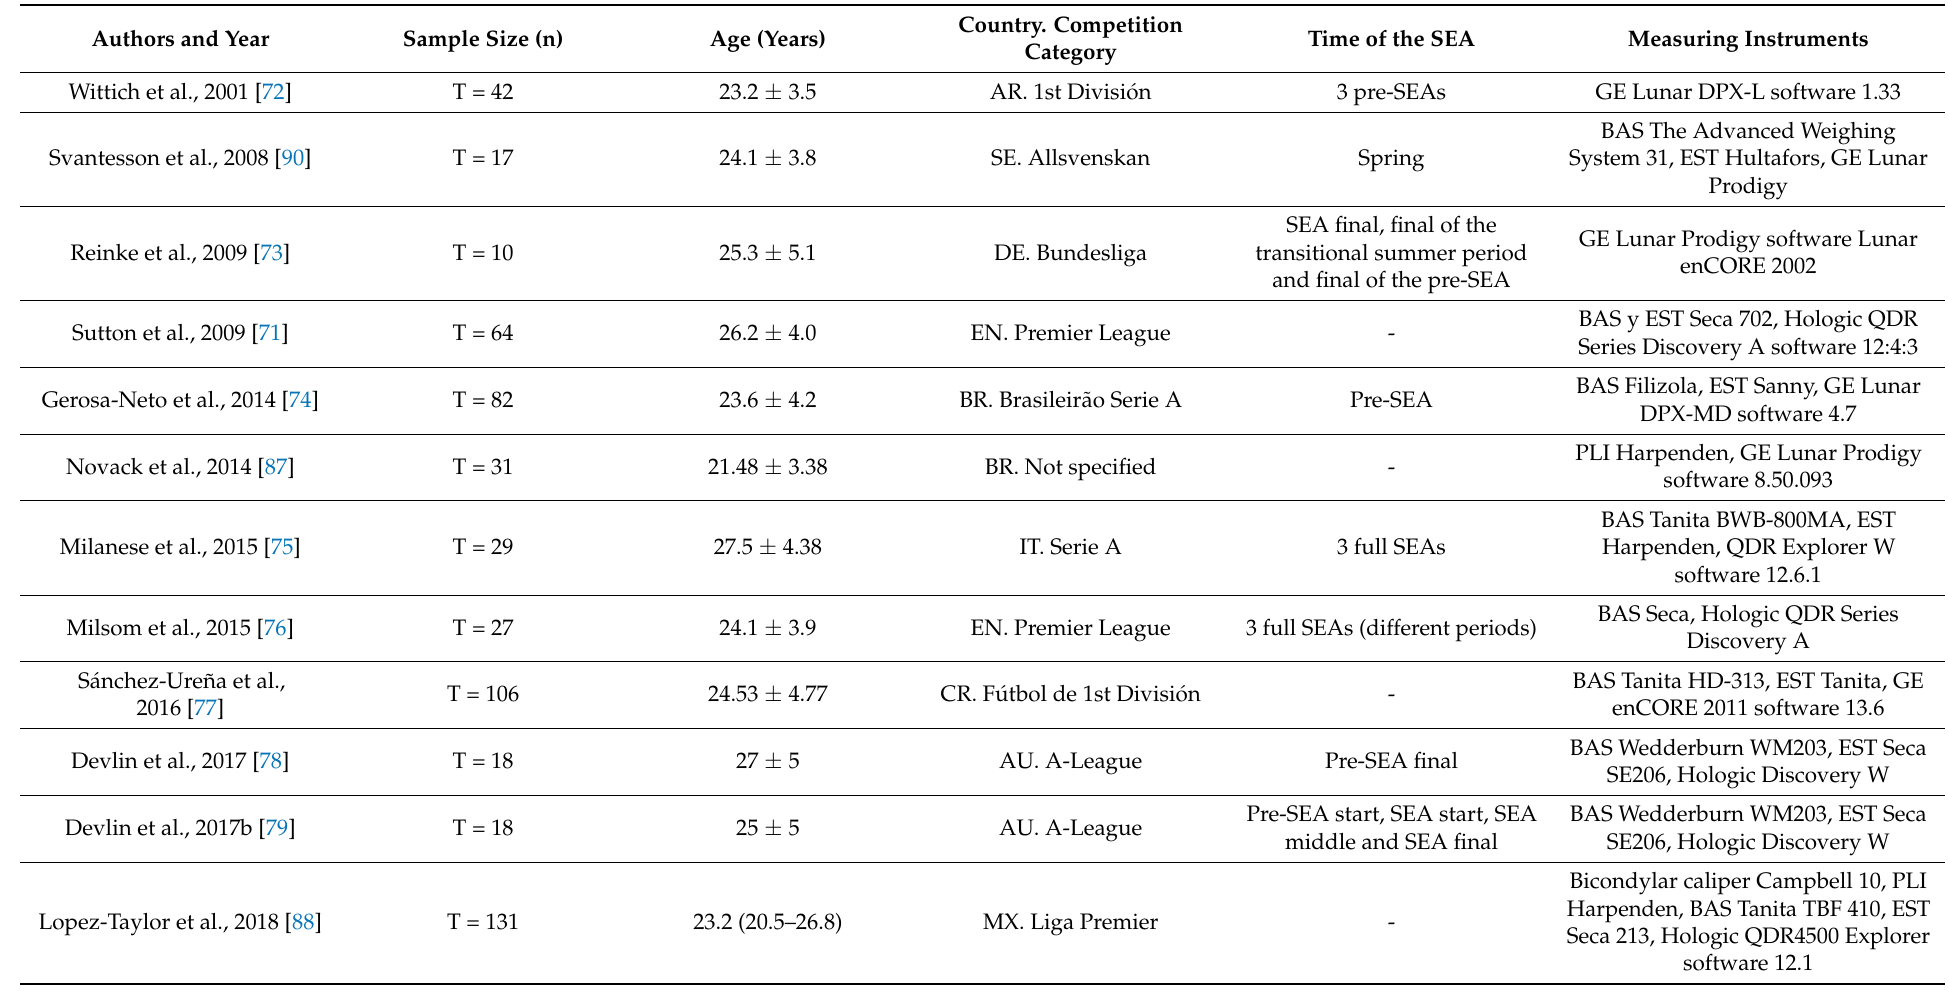
Table 4. Descriptive characteristics of the included studies with